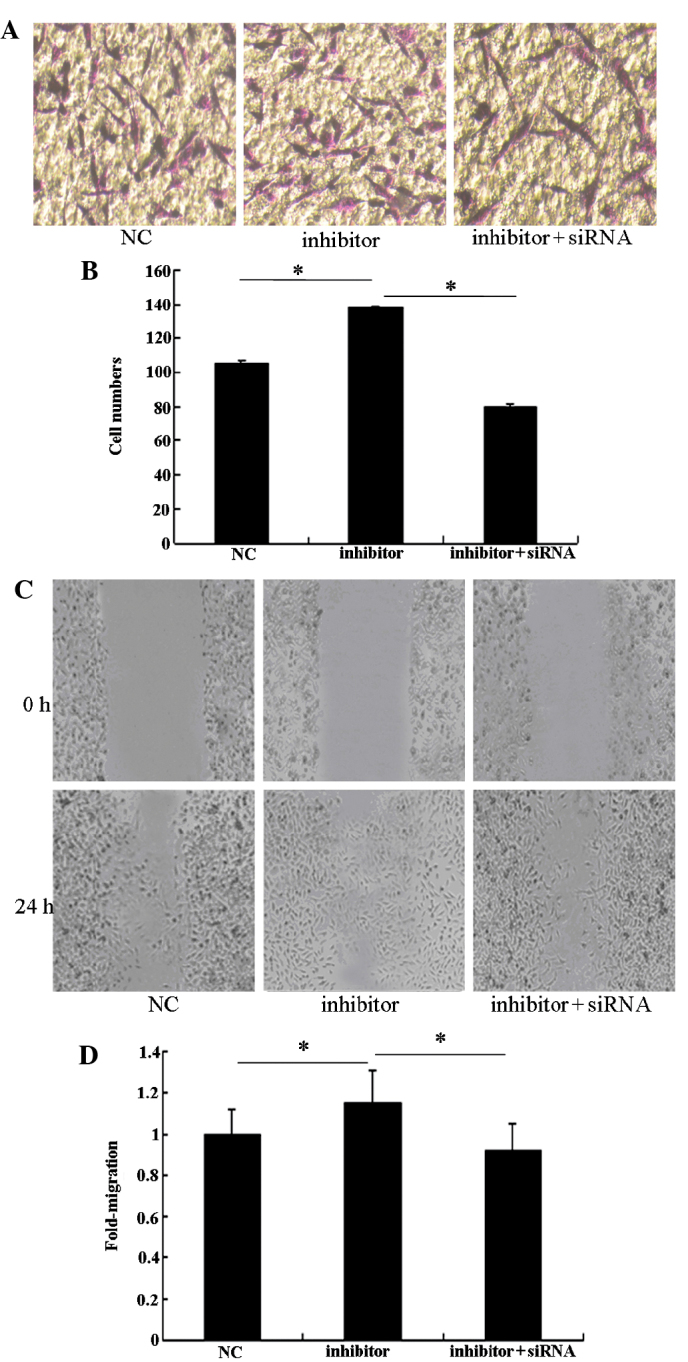
In the U87 cell line, Robo1 siRNA reduced miR-218 inhibitor-induced enhanced invasive ability. (A and B) Transwell assays revealed that the miR-218 inhibitor promoted the invasion of U87 cells and Robo1 siRNA attenuated the invasion. *P<0.05. (C and D) Robo1 siRNA attenuation of the migration of U87 cells was also observed in the scratch-wound assay. *P<0.05. NC, negative control; siRNA, small interfering RNA; Robo1, roundabout, axon guidance receptor, homolog 1; miR-218, microRNA 218.